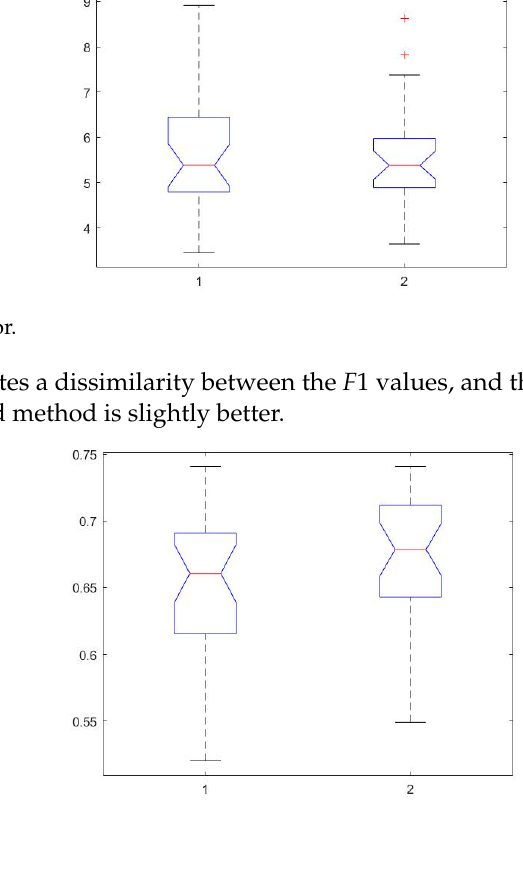
3. POCID indicator. The result indicates a relative similarity between the POCID values, but the one corresponding to the proposed method is slightly better.